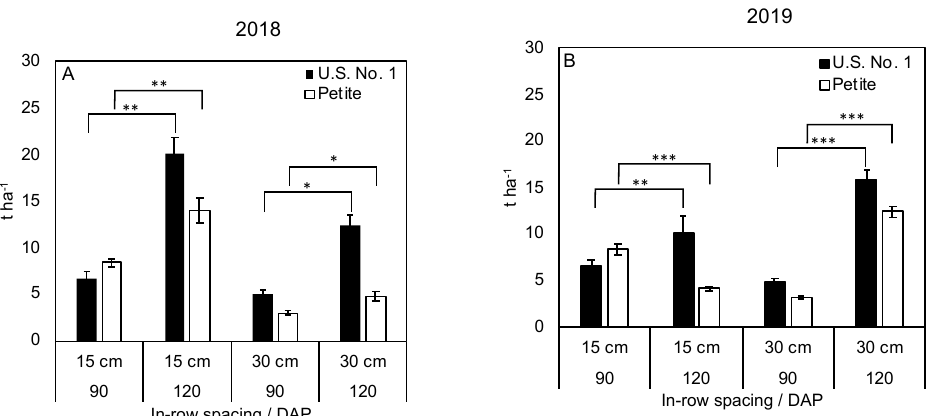
Figure 3. Main effects of in-row spacing and days after planting on total and marketable yields of sweet potato for the 2018 ( A ) and 2019 ( B ) field seasons. Error bars are one standard error from the mean. Statistically significant comparisons are indicated on the graphs with ** and *** denoting, respectively a p -value ≤ 0.01 and 0.001. DAP = days after planting; TY = total yield; MY = marketable yield.